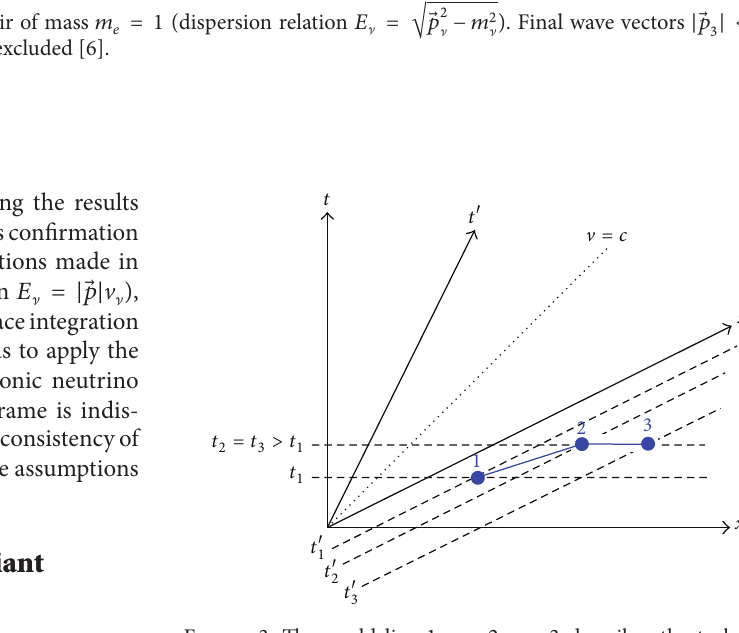
= 1 (dispersion relation 𝐸 = √ ⃗𝑝 2 − 𝑚 2 | ⃗𝑝 | < 𝑚 𝑒 ] ] ] ). Final wave vectors 3 ]